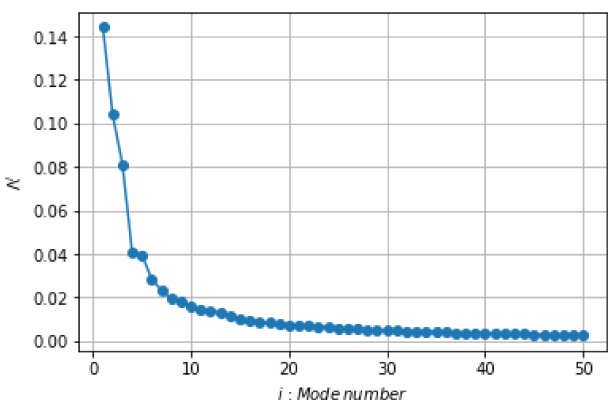
Figure 10. Energy content of each of the first 50 POD